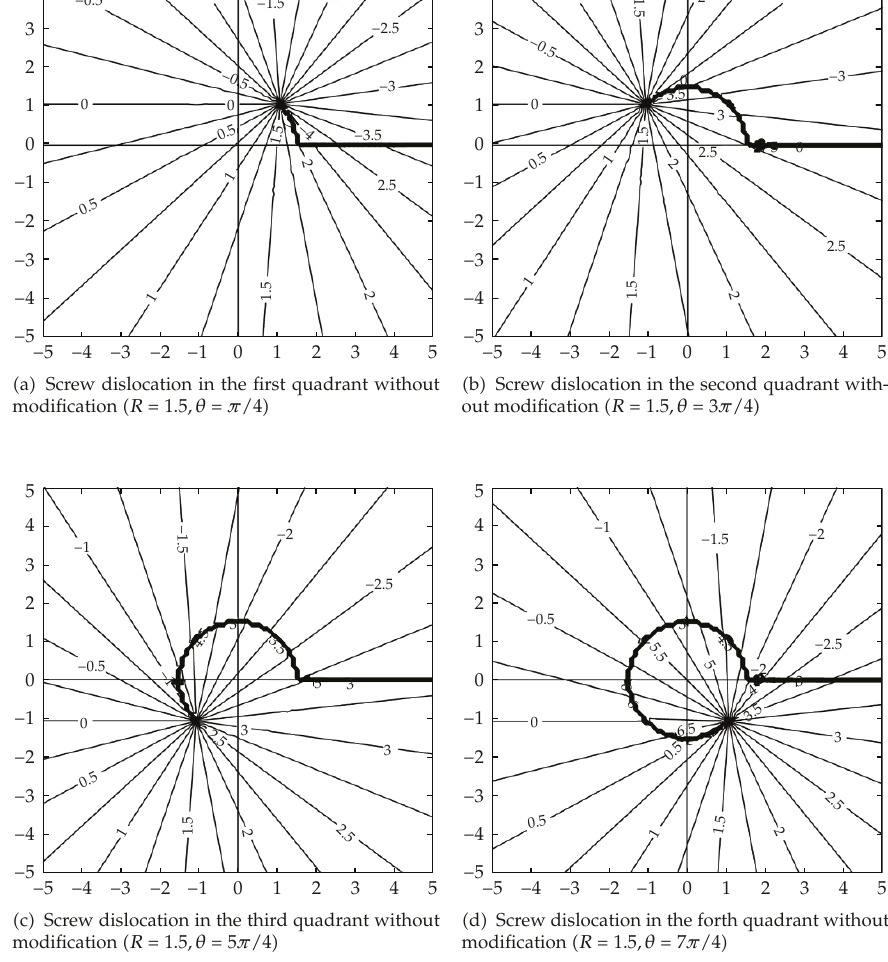
Figure 3: Screw dislocation in (cid:5) a (cid:6) the first, (cid:5) b (cid:6) the second, (cid:5) c (cid:6) the third, and (cid:5) d (cid:6) the forth quadrant without